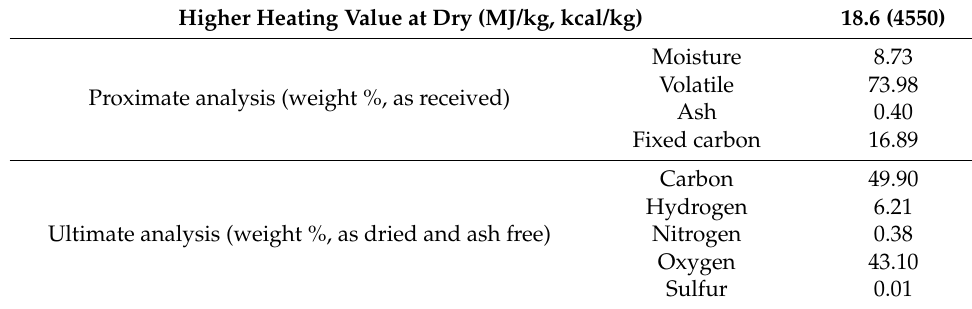
Table 1. Proximate and ultimate analysis results of tested wood pellet. (Korea Institute of Energy Research, Testing and Certification Center).